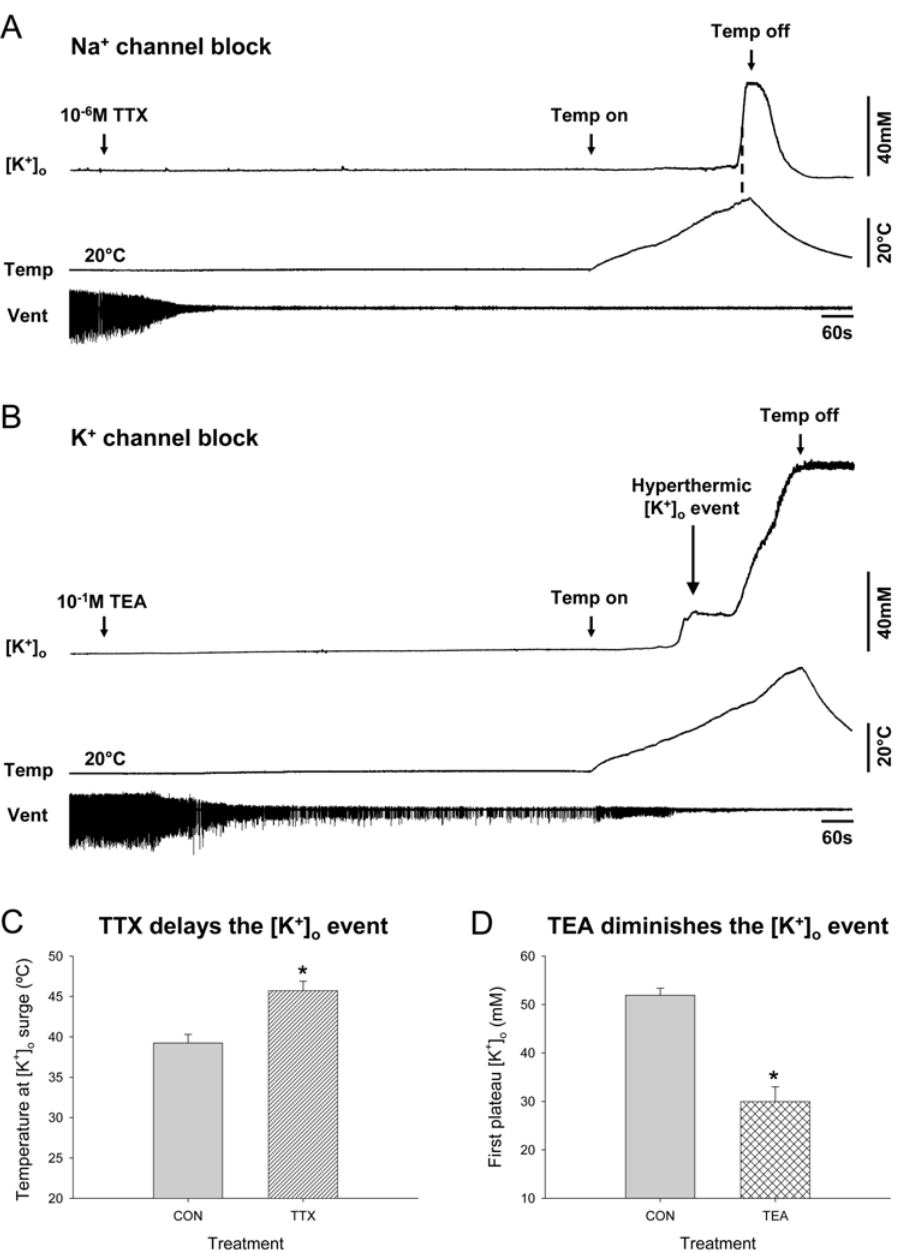
Figure 4. The hyperthermic [K + ] o event is delayed by blocking Na + channels and neural activity using TTX and is diminished by blocking K + channels using TEA. A. 10 2 6 M TTX abolished electrical activity within minutes while [K + ] o remained stable. The abrupt rise in [K + ] o was not significantly diminished by TTX. The hyperthermic [K + ] o event occurred at a significantly higher temperature (measured at dotted line) in the absence of electrical activity (46 6 1 u C) compared to CON locusts (39 6 1 u C) ( C ) (N CON =17; N TTX =15). B. 10 2 1 M TEA significantly reduced the hyperthermic [K + ] o event (N CON =17; N TEA =6) ( D ). [K + ] o increased with continued temperature increase to , 60 u C.